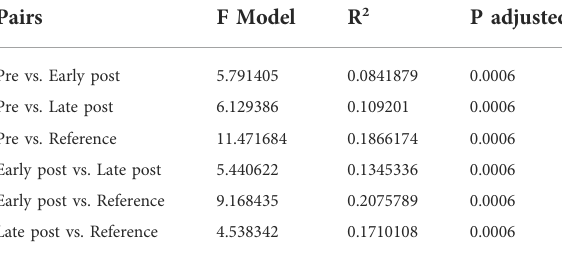
TABLE 3 Permutational multivariateanalysisof variance pairwise tests comparing the taxonomic composition of benthic macroinvertebrate assemblages of rehabilitated and reference sites over time